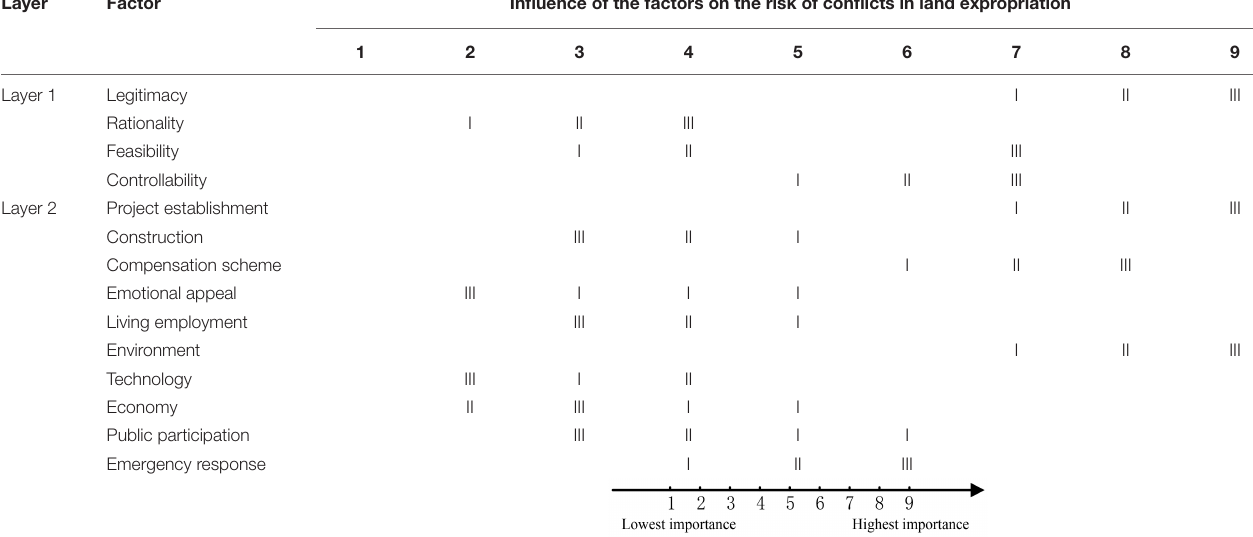
TABLE A1 | Questionnaire for risk assessment of conflicts in land expropriation.